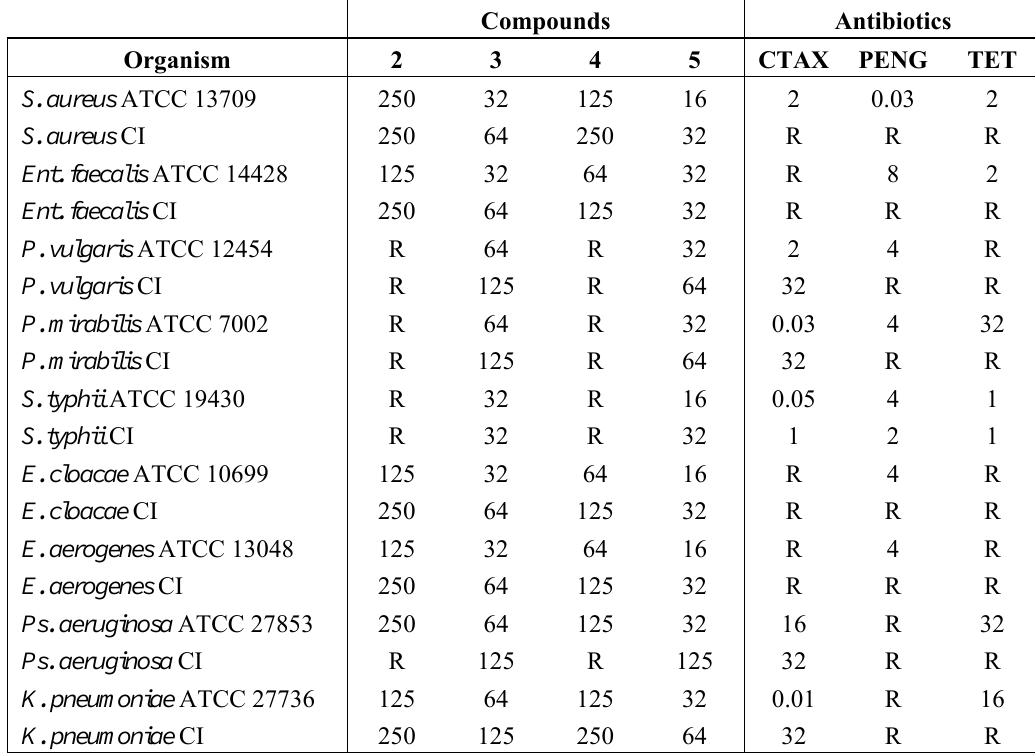
Table 1 . Antibacterial activity (MIC values μ g/mL) of compounds 2 – 5 and of reference antibiotics.